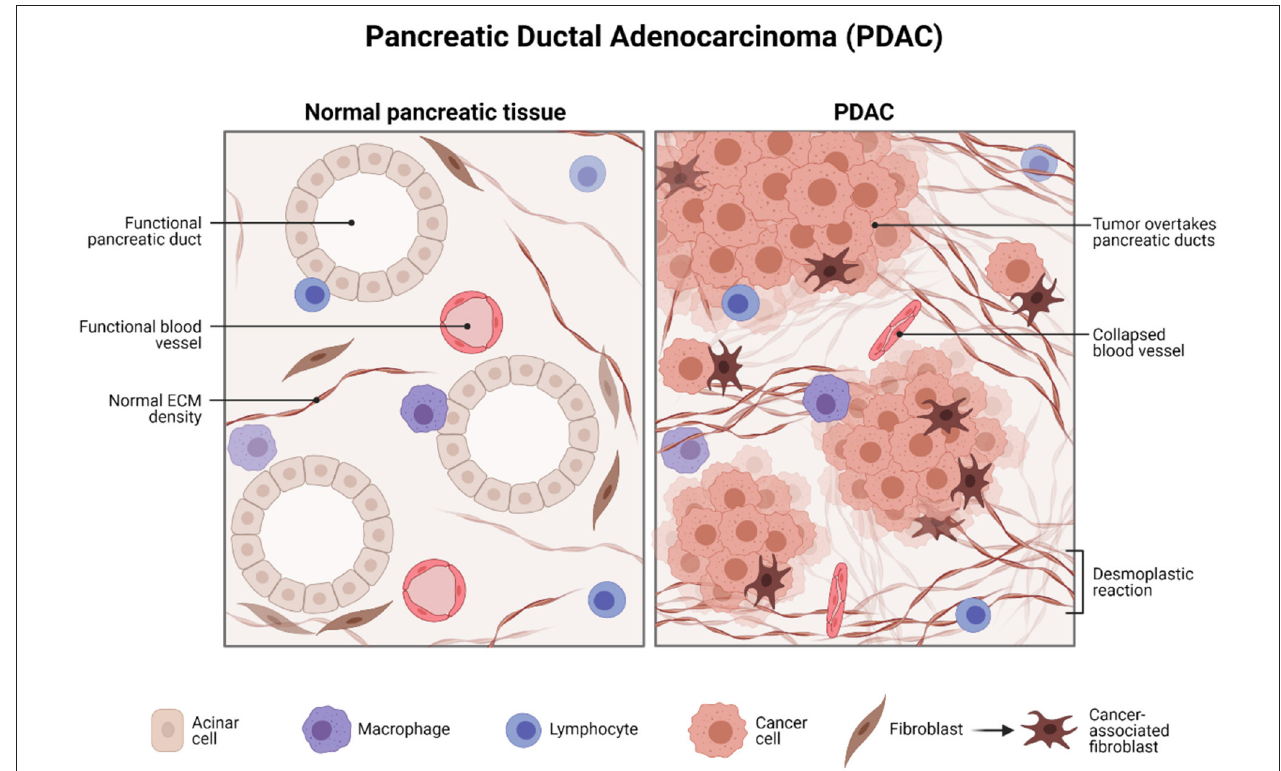
FIGURE 1 | Histology of pancreatic ductal adenocarcinoma. Created with